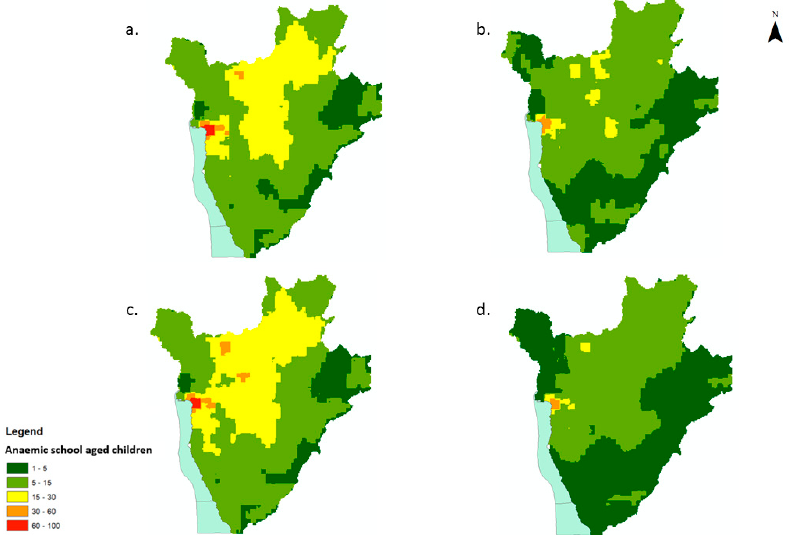
Figure 2. Estimated number of anaemic school-aged children (5–15 yrs) in Burundi, 2008–2011, per 550 m 2 pixel. ( a ) 2008, ( b ) 2009, ( c ) 2010, ( d )